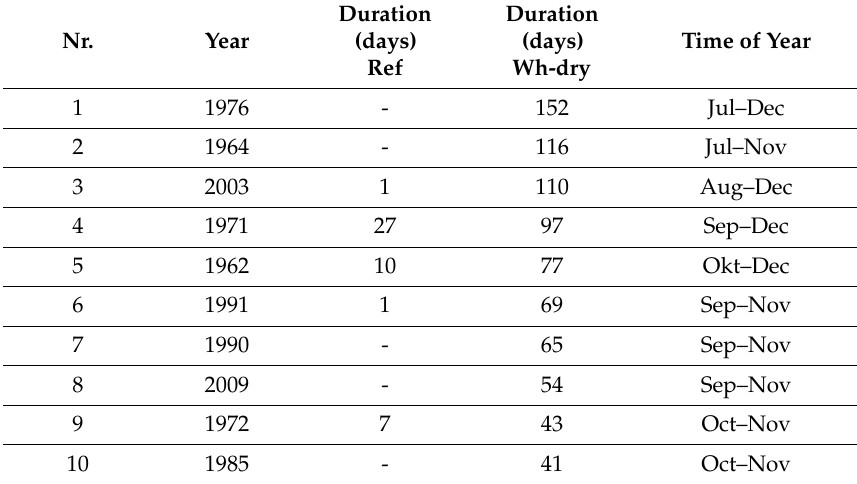
Table 3. The 10 longest periods of exceedance of the chloride threshold concentration (150 mg/L) at Bergambacht (direct intake of river water) in the reference situation (current climate) and the future climate Wh-dry scenario. Sorted on highest to lowest durations under Wh-dry conditions. Duration Duration (days) Time of Year Nr. Year (days) Wh-dry Ref